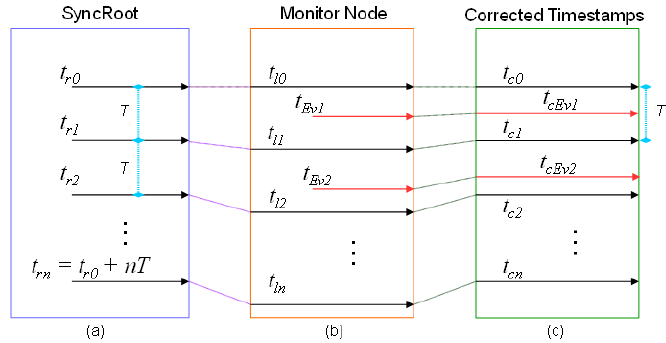
Figure 5. Schematic of global trace synchronization method. ( a ) The SyncRoot generates the sync points periodically; ( b ) The Monitor Node registers events and synchronization points; ( c ) The timestamps are corrected.